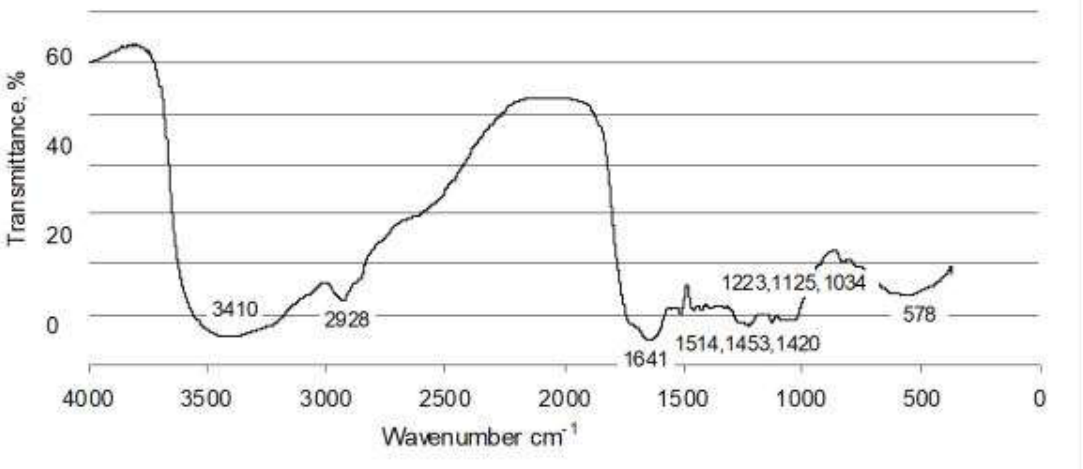
Figure 4. DRIFT (Diffuse Reflectance Infrared Fourier Transform) spectrum of humic acids extracted from forest litter (FL).